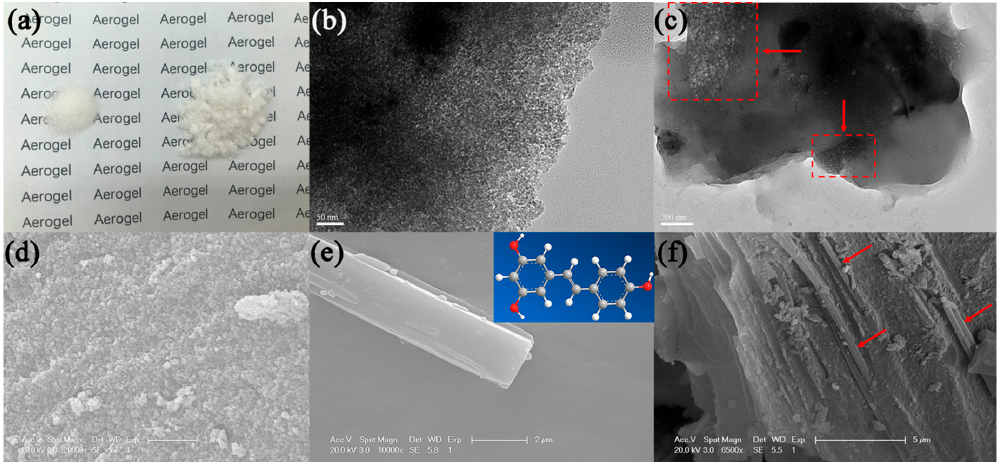
Figure 1. ( a ) The appearance of silica aerogel (left) and trans-resveratrol (RSV)-loaded silica aerogel (RLSA) (right) after freeze drying; ( b , c ) Transmission electron microscope (TEM) images of silica aerogel and RLSA; ( d – f ) Scanning electron microscope (SEM) images of silica aerogel, RSV and RLSA.